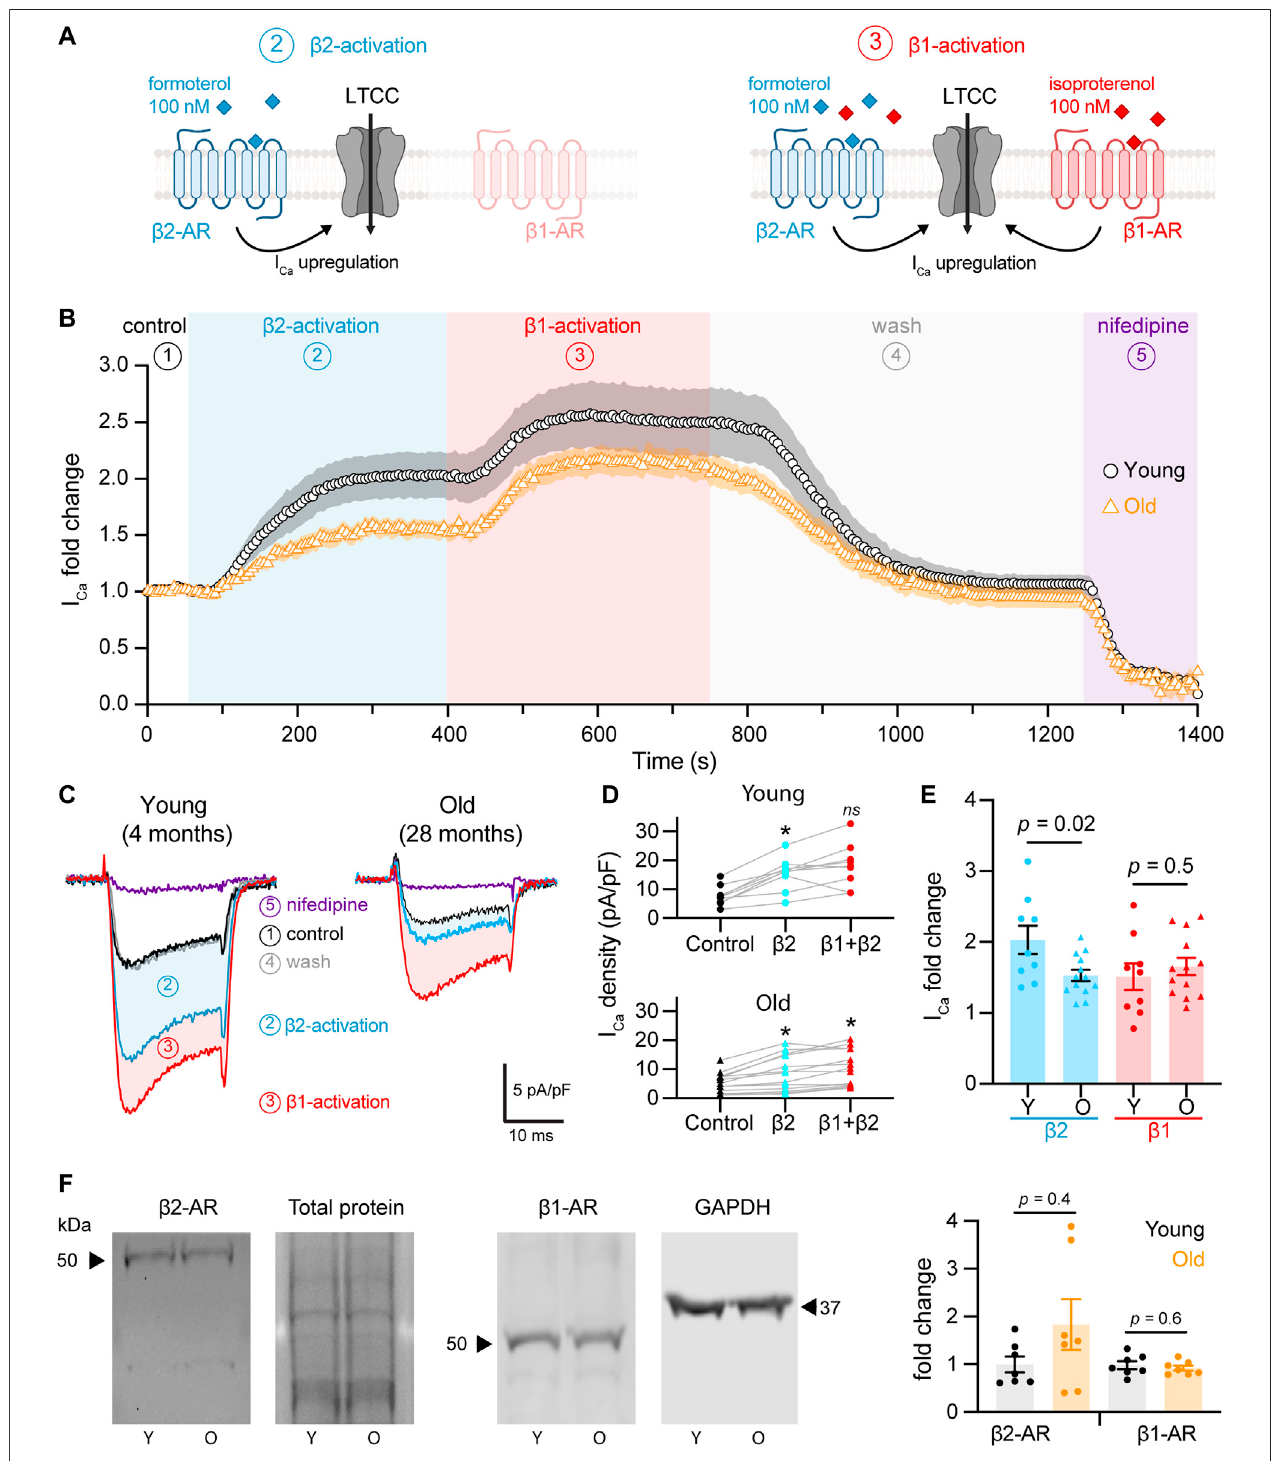
FIGURE 2 | Aging reduces β 2-but not β 1-mediated regulation of L-type calcium currents in pacemaker cells. (A) Diagrammatic representation summarizes the protocol used to isolate β 2 from β 1-AR upregulation of calcium currents, which consisted in the stimulation using 100 nM formoterol followed by the simultaneous stimulation with 100 nM formoterol +100 nM isoproterenol. Diagram created with BioRender.com. (B) Time course of calcium current fold change in control conditions (1) β 2-speci fi c activation (2) β 1-activation (3), washout (4), and lastly with nifedipine to block LTCCs (5) in young (black circles, n = 10 cells, N = 3 animals) and old (orangetriangles,n=14cells,N=4animals)pacemakercells. (C) RepresentativecalciumcurrentsfromthetimecourseinB. (D) Calciumcurrentdensityregulationafter